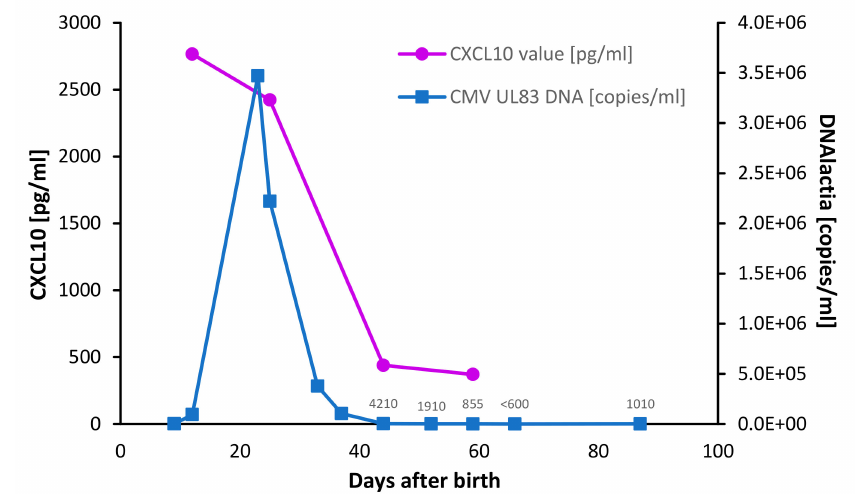
Figure 1. Exemplary course of viral shedding into breast milk during the first months of lactation (mother 3); cytomegalovirus (HCMV) DNA viral load, measured by qPCR targeting UL83